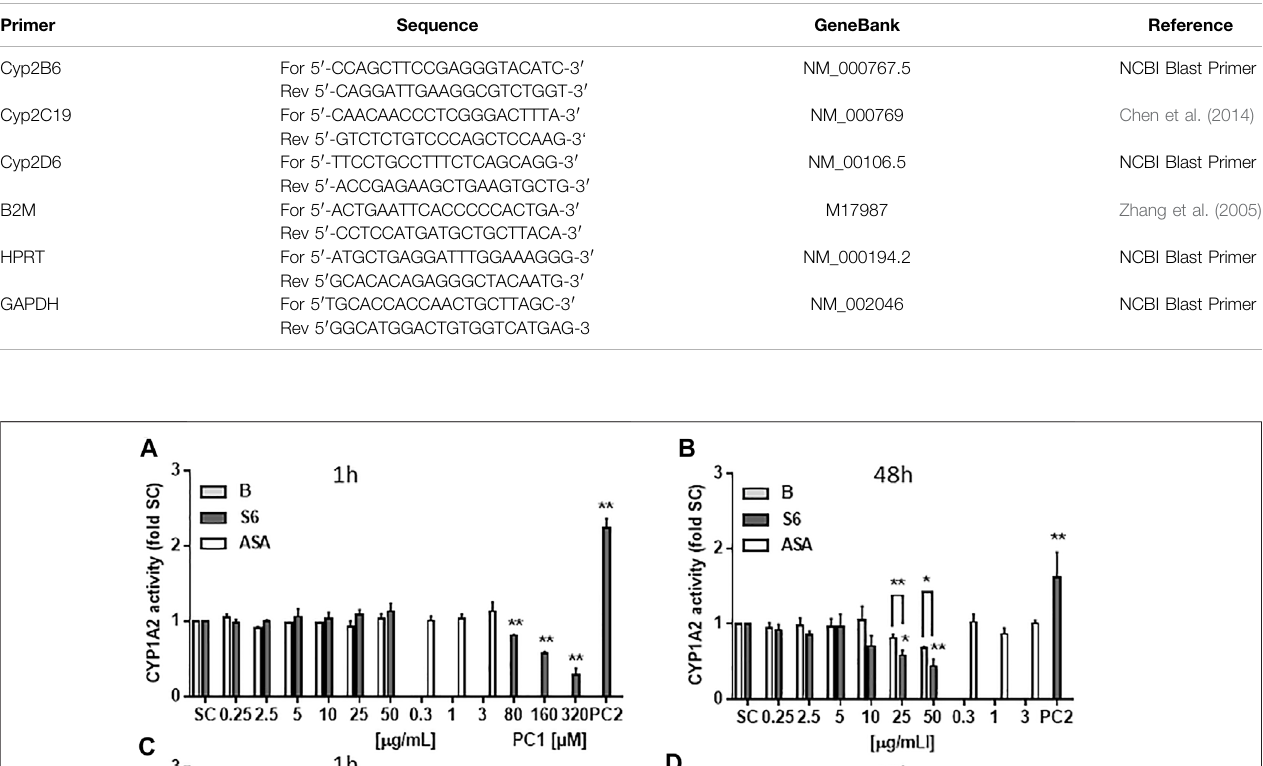
TABLE 1 | Sequences of speci fi c primers.